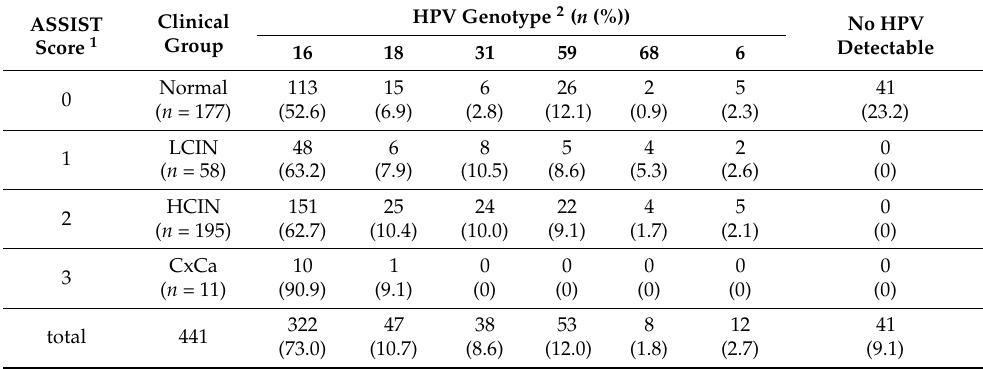
1 ASSIST score: composite result score of the patients’ cytology, colposcopy, and histology findings. 2 HPV genotypes included in the QG-POC assay. HPV, human papillomavirus; LCIN, low-grade intraepithelial lesion; HCIN, high-grade intraepithelial lesion; CxCa, invasive cervical cancer; MPG, multiplexed